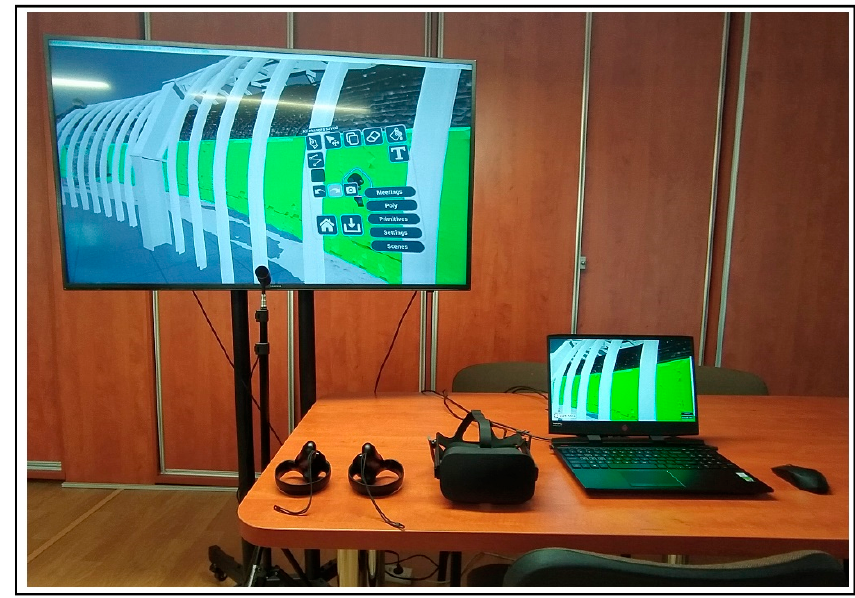
Figure 22. Stand for design presentation with use of Virtual Reality [31].